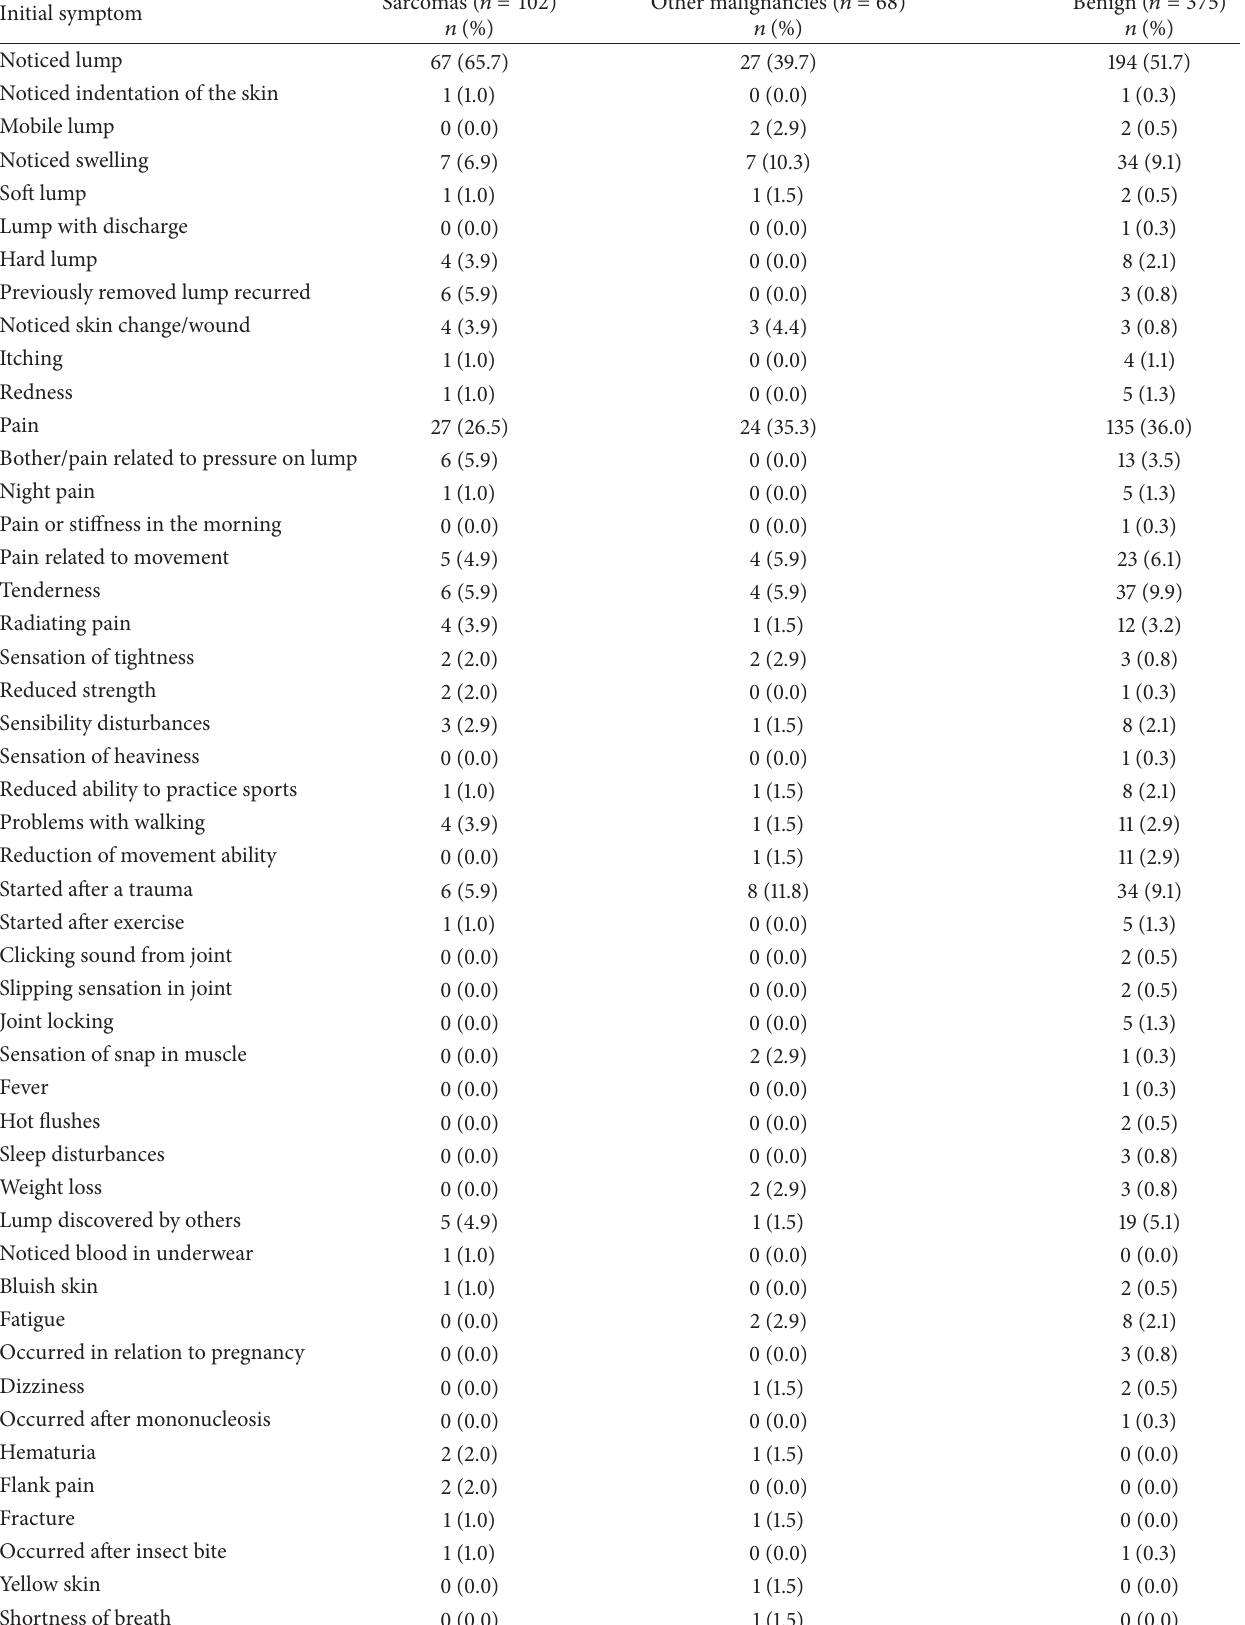
Table 3: Patient reported initial